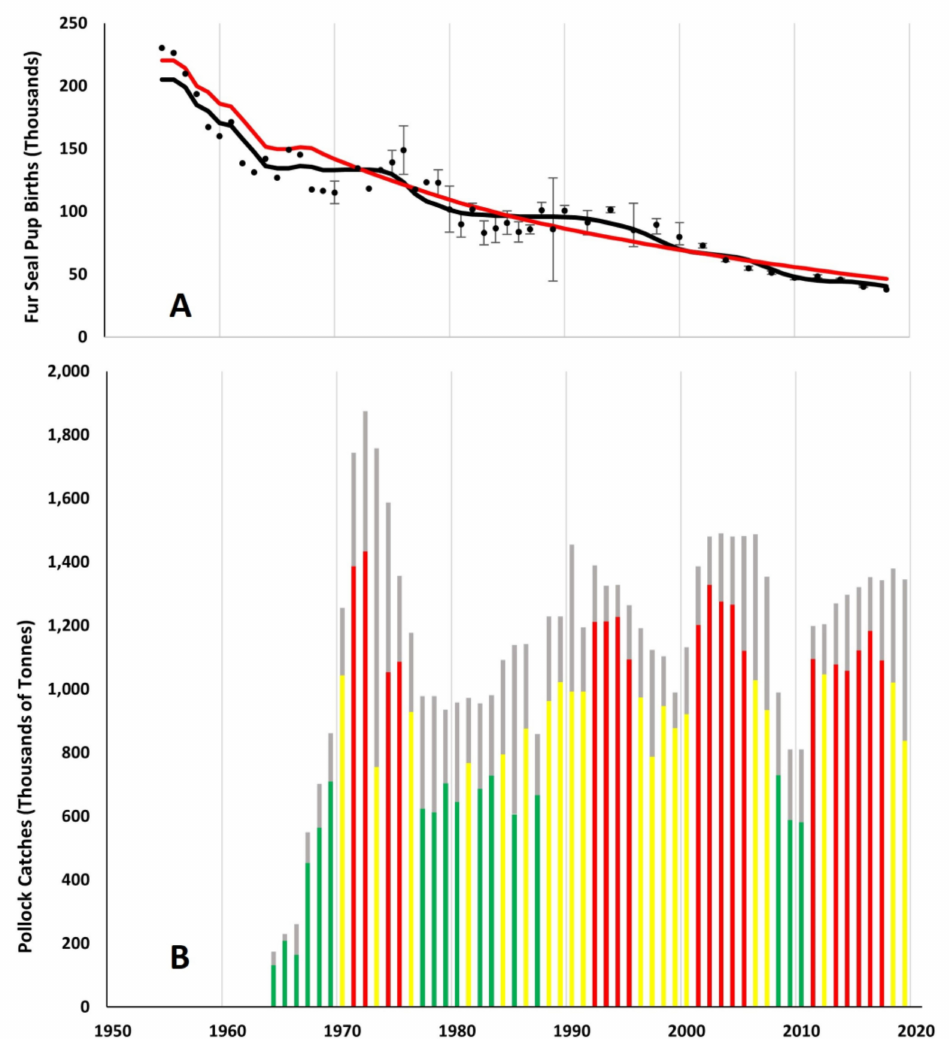
Figure 2. ( A ) Observed pup counts on St. Paul Island and predicted pup counts from deterministic models of pup births driven by pollock catch from our Pribilof fur seal foraging area (Model 1, black line) and by estimated age-3+ pollock biomass from the eastern Bering Sea stock assessment [23] (Model 2, red line). ( B ) Annual pollock commercial catches (metric tons) inside our fur seal foraging area during low (green bars), medium (yellow bars), and high (red bars) catch years, and annual total pollock eastern Bering Sea pollock catch (gray